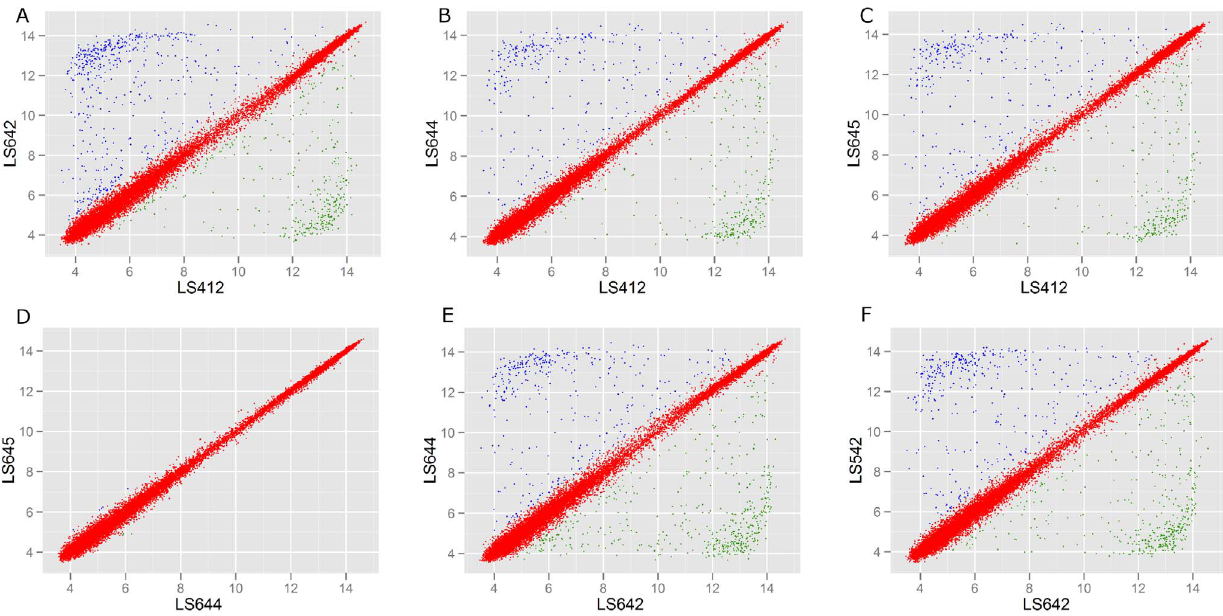
Figure 5. Scatter plots of the summarized Robust Multi-Array Averaging (RMA) intensities. A–C, between serotypes 4b (LS412) and IVb- v1 (LS642, A; LS644, B; LS645, C). D–E, between the same serotype, IVb-v1, isolated from Australia; from the different states (LS644 and LS645, D); from the same state (LS642 and LS644, E). F, between the same serotype, IVb-v1, isolated from the different countries (LS642; Australia and LS542; USA).